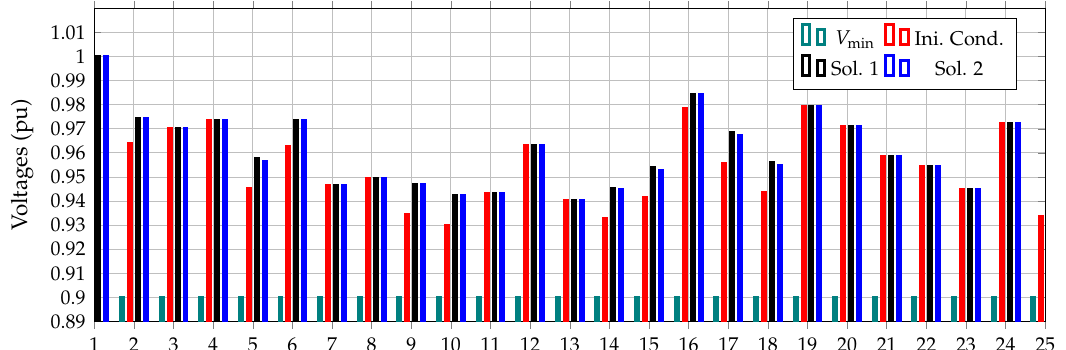
Figure 6. Voltage profiles in phase a for all the solutions reported in Table 11.